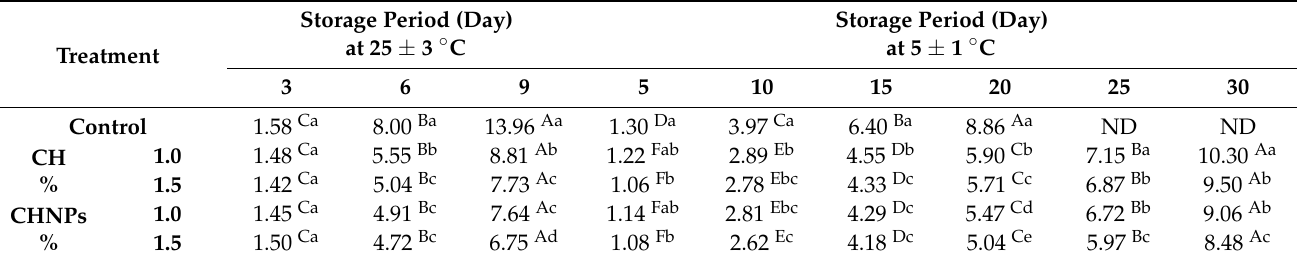
Mean values in the same row (as a capital letter) or column (as a small letter) with different letters are significantly different ( p < 0.05). ND: not determined. For each parameter (row), different capital letters (A, B, C, D, E, F) in superscript indicate significant differences at p < 0.05 among storage treatments. For each column, different small letters (a, b, c, d, e) in superscript indicate significant differences at p < 0.05 among treatments for each measured